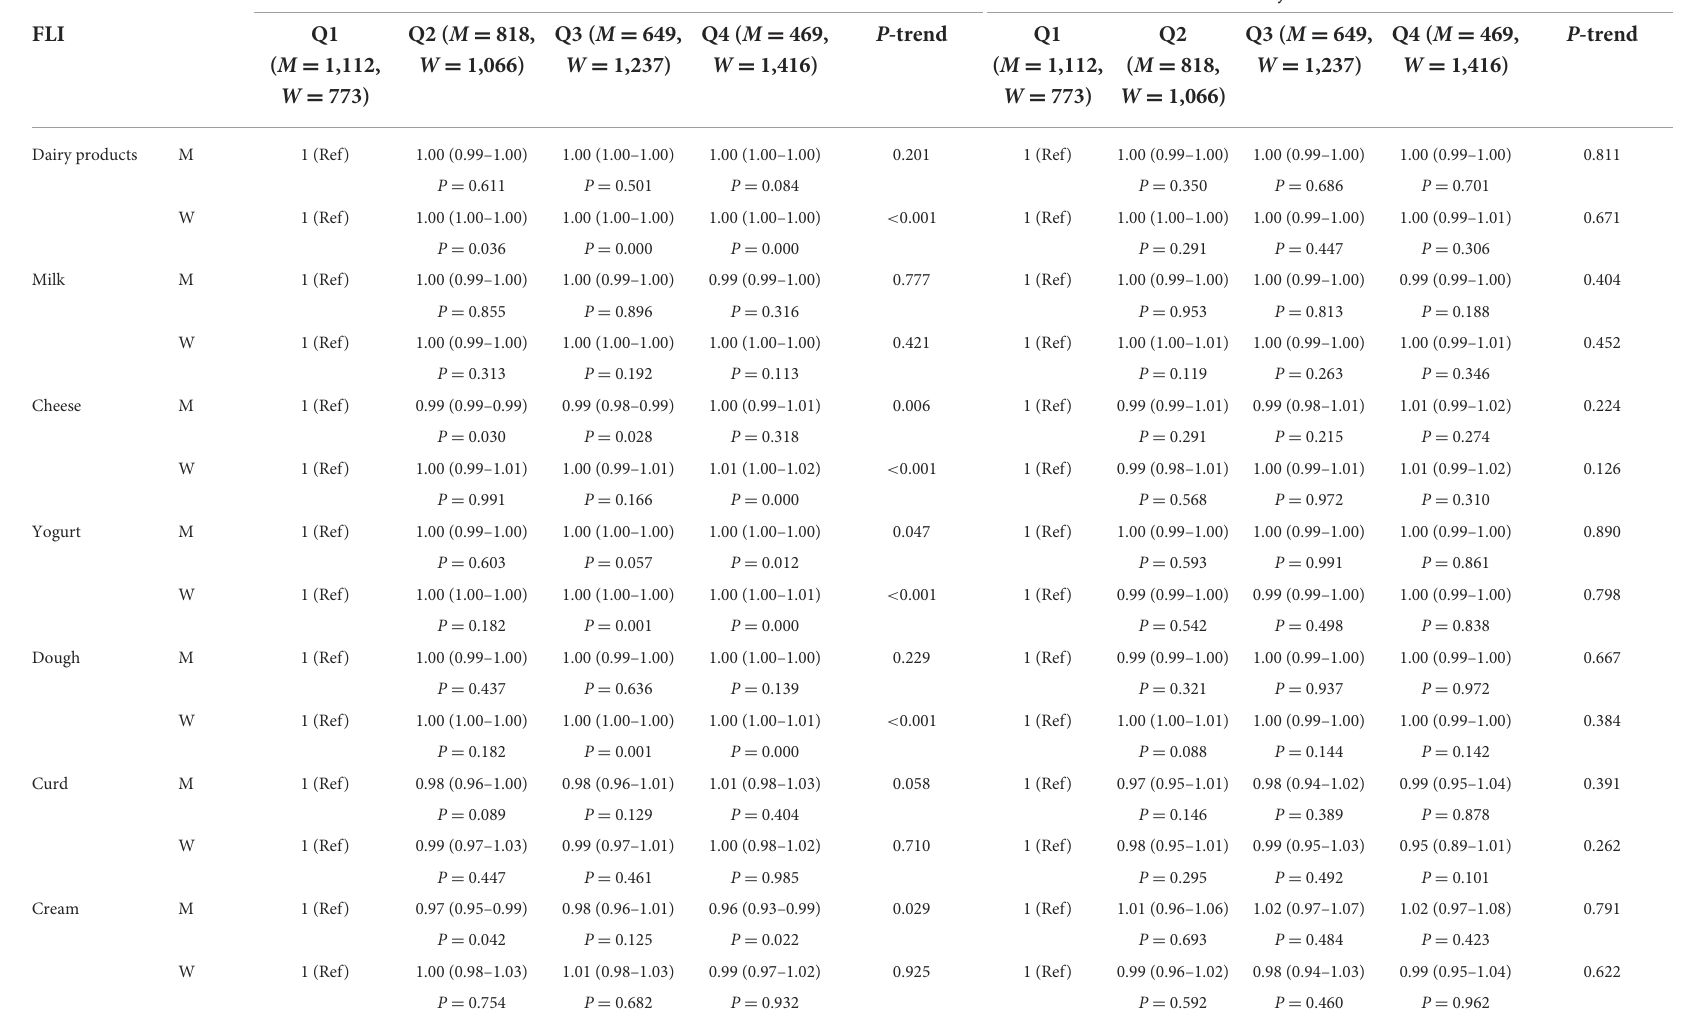
TABLE 3 Odds ratio (95% CI) from multiple logistic regression by dairy food